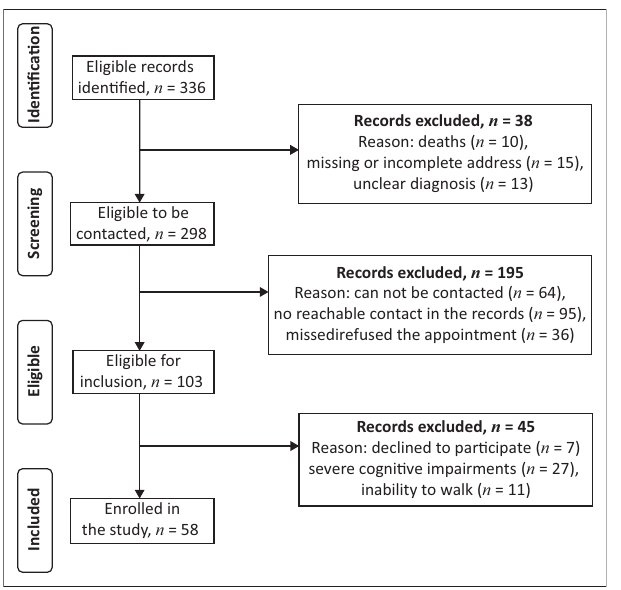
FIGURE 1: Flow chart of participant eligibility and inclusion. TABLE 2: Descriptive data of walking speed, balance, activity limitations and participation. Sub-groups according to the walking speed on 10 mWT (m/s).